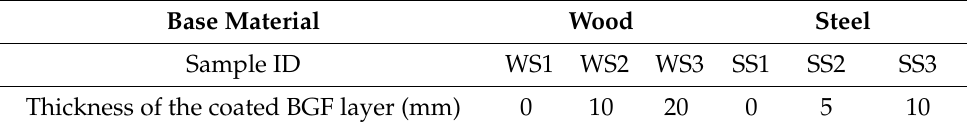
Table 3. Wood and steel samples for fire resistance